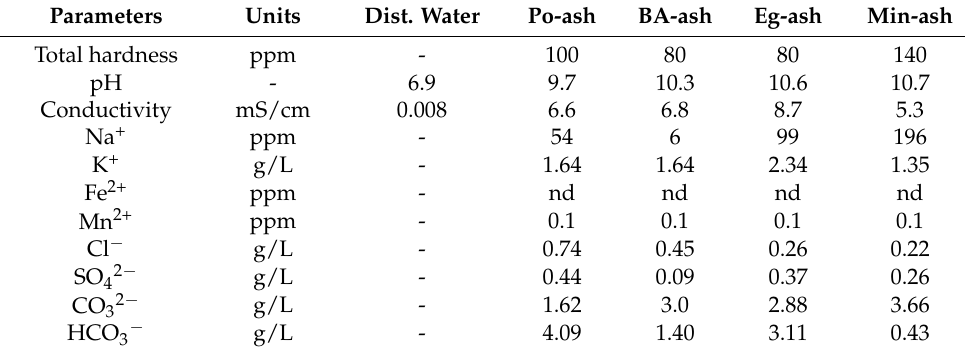
Table 4. Changes in water quality after adding 10 g/L of ash materials in 1000 ppm Ca ions.